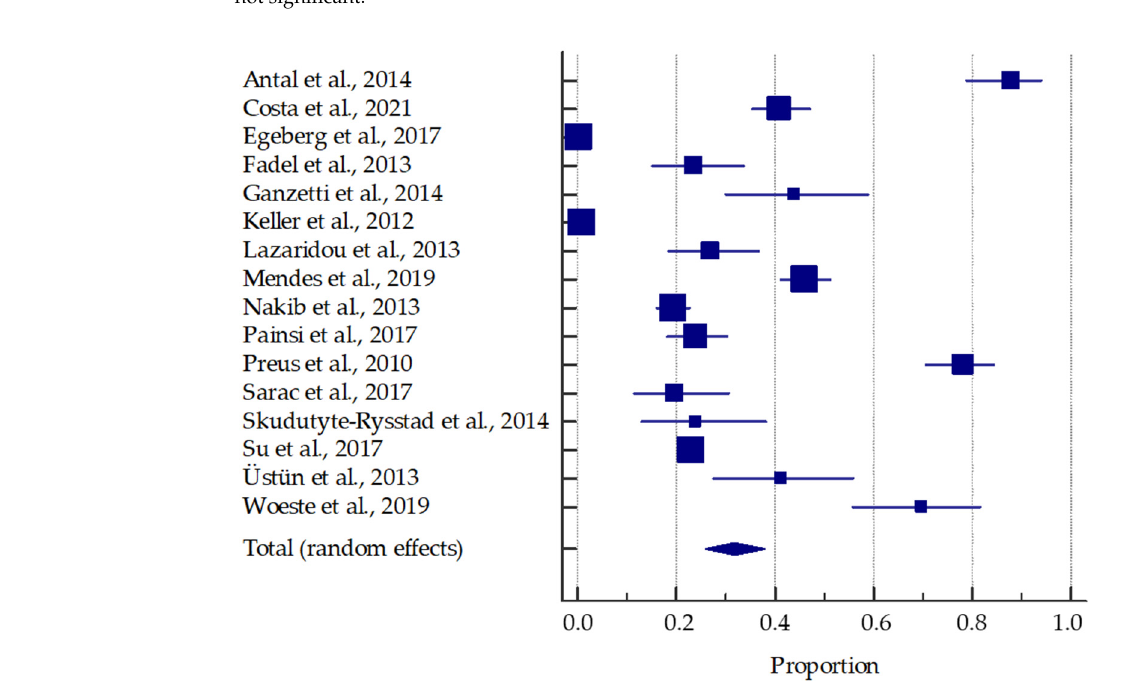
Figure 4. Forest plot presenting the odds for periodontal disease in patients with psoriasis (OR: odds ratio; CI: confidence interval) [33–35,40–52]. 4. Discussion